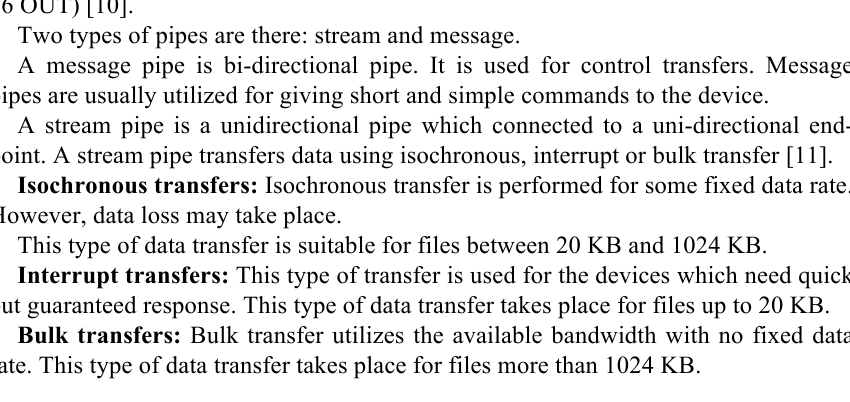
Short Paper— Computer Independent Data Transfer